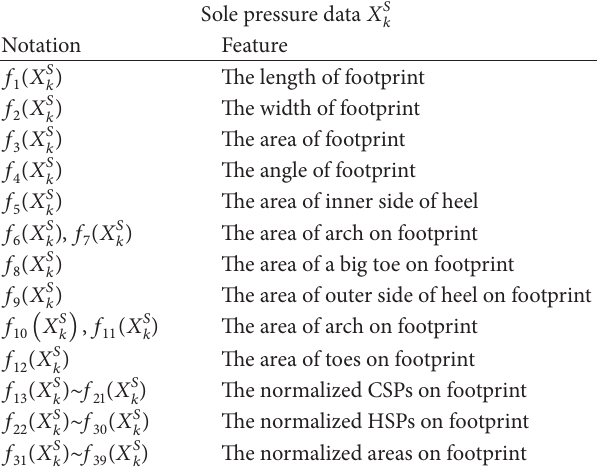
Table 1: Features of each sole pressure data.